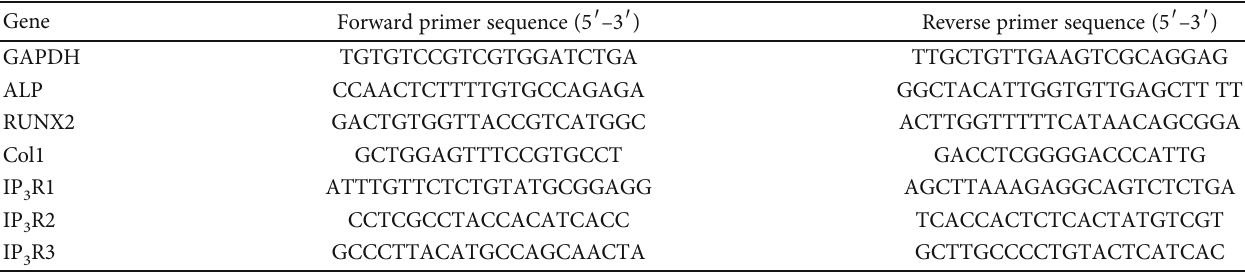
Table 3: Primers used for